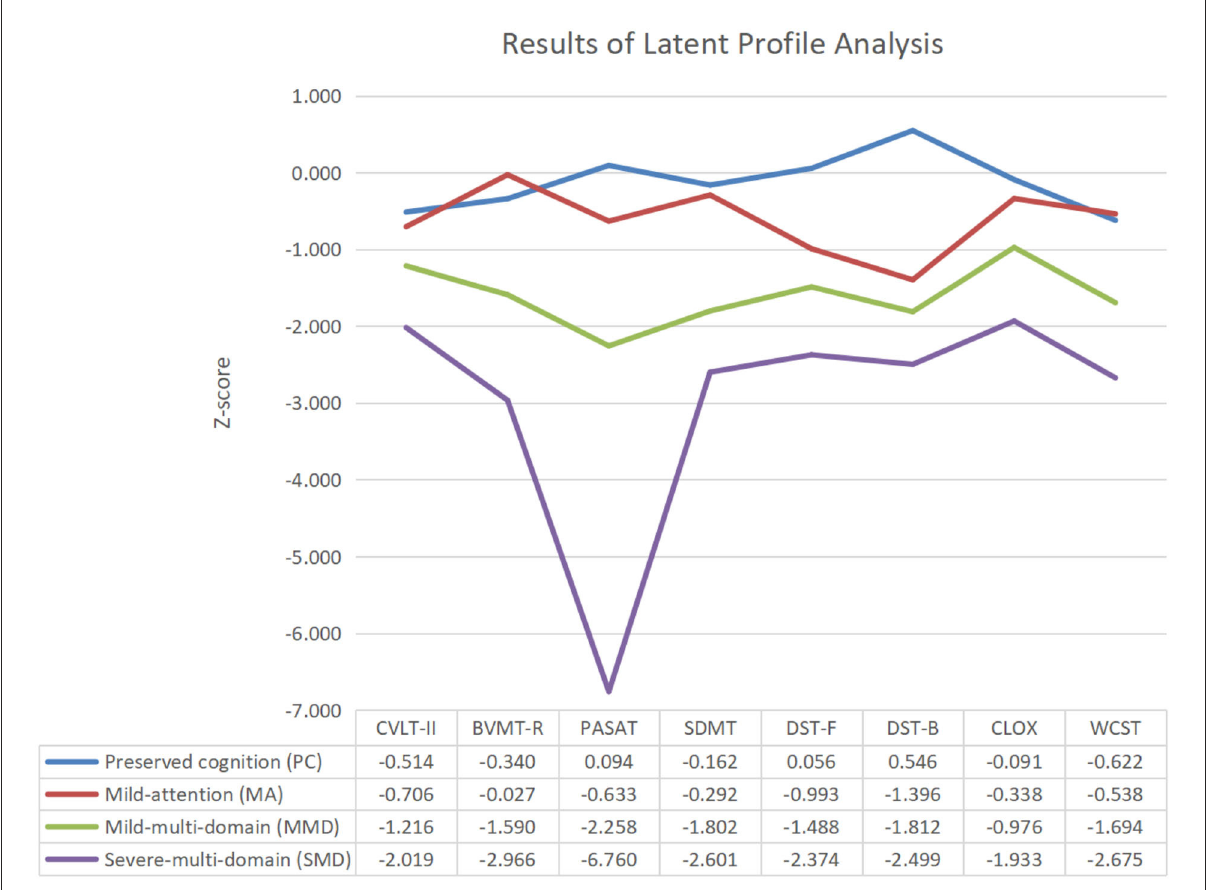
FIGURE1 Results of the latent profile